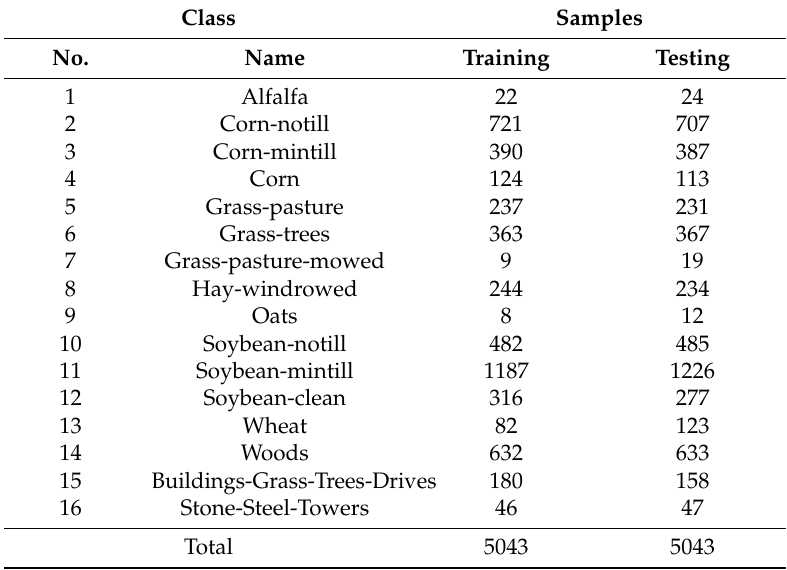
Table 3. Color coding and sample size for Indian pines